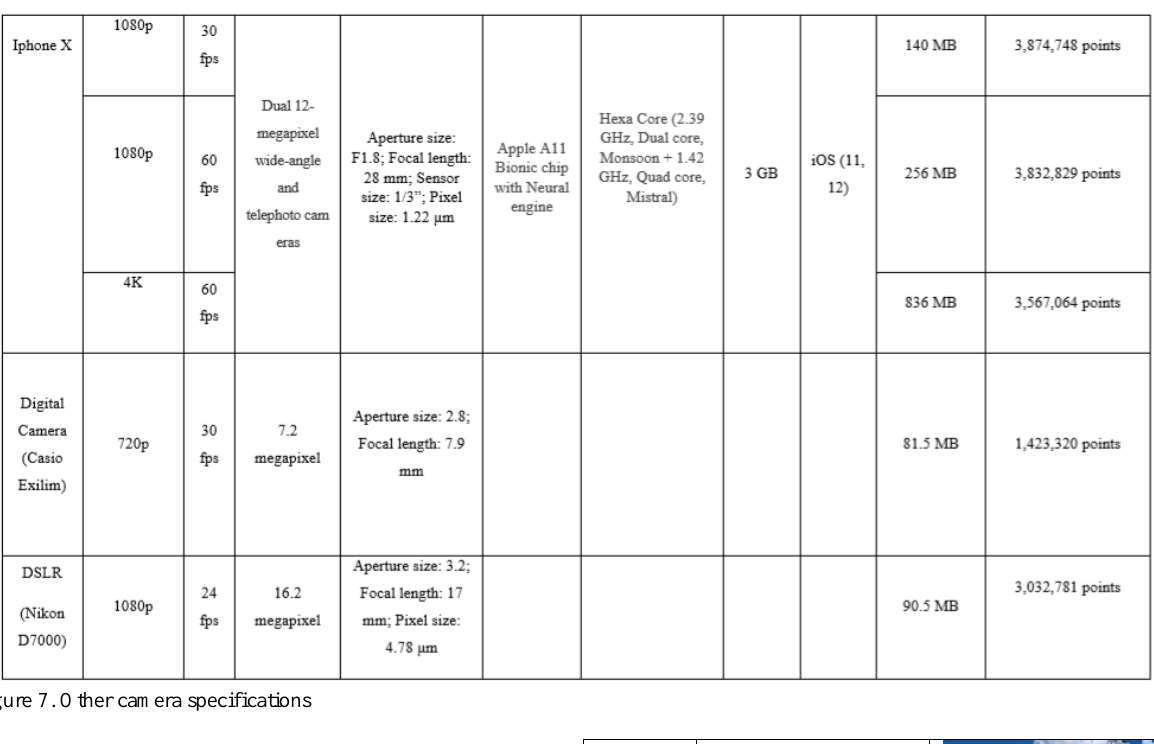
Figure 7. Other camera specifications